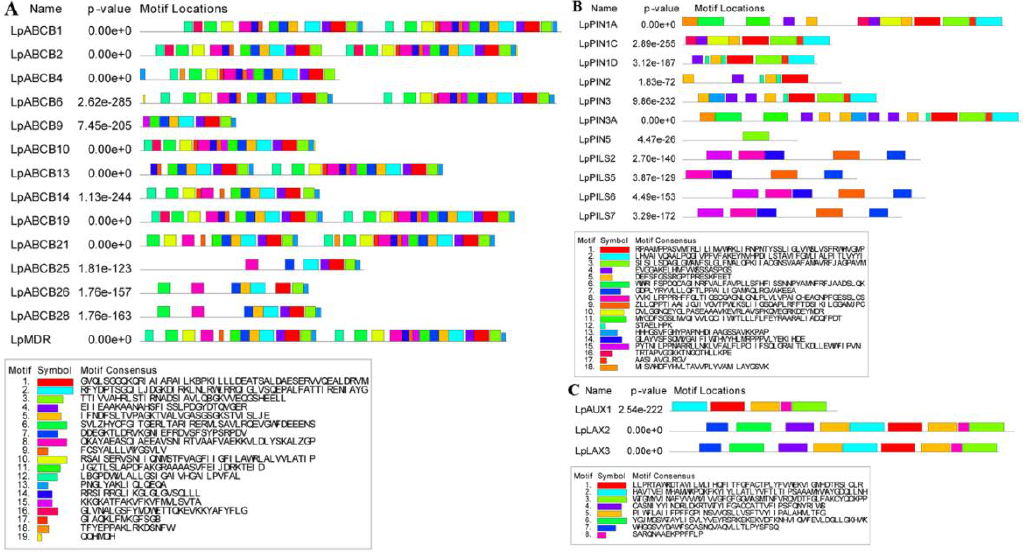
Figure 5. Motif analysis of fourteen LpABCBs ( A ), eleven LpPINs/PILSs ( B ) and three LpAUX/LAXs ( C ).